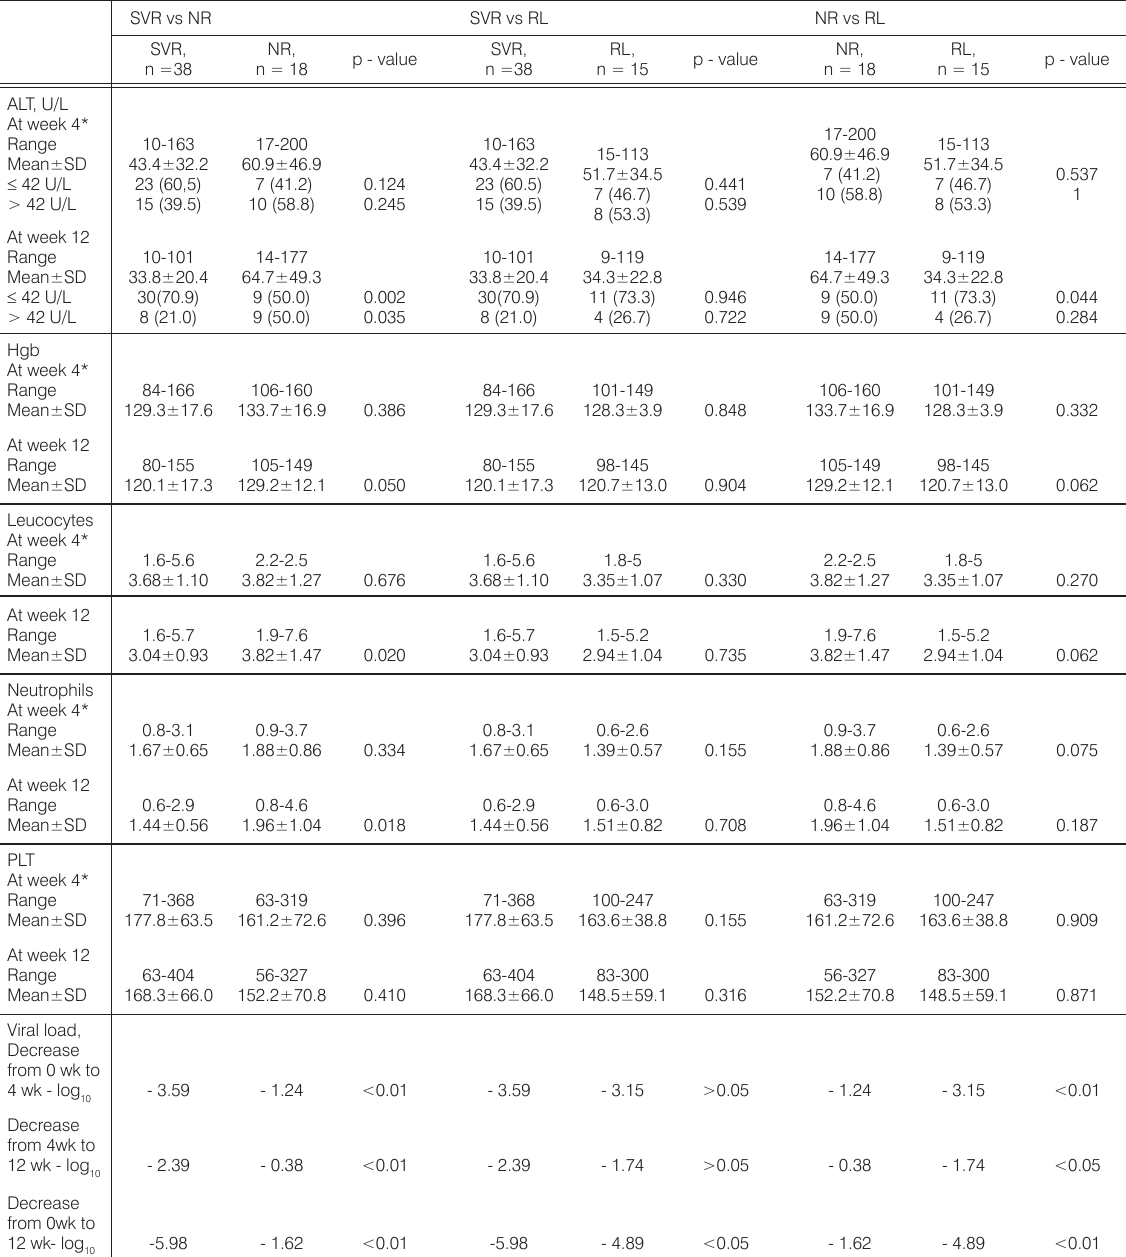
Table 2. On-treatment clinical features of studied patients at weeks 4 and 12: SVR vs NR, SVR vs RL, NR vs